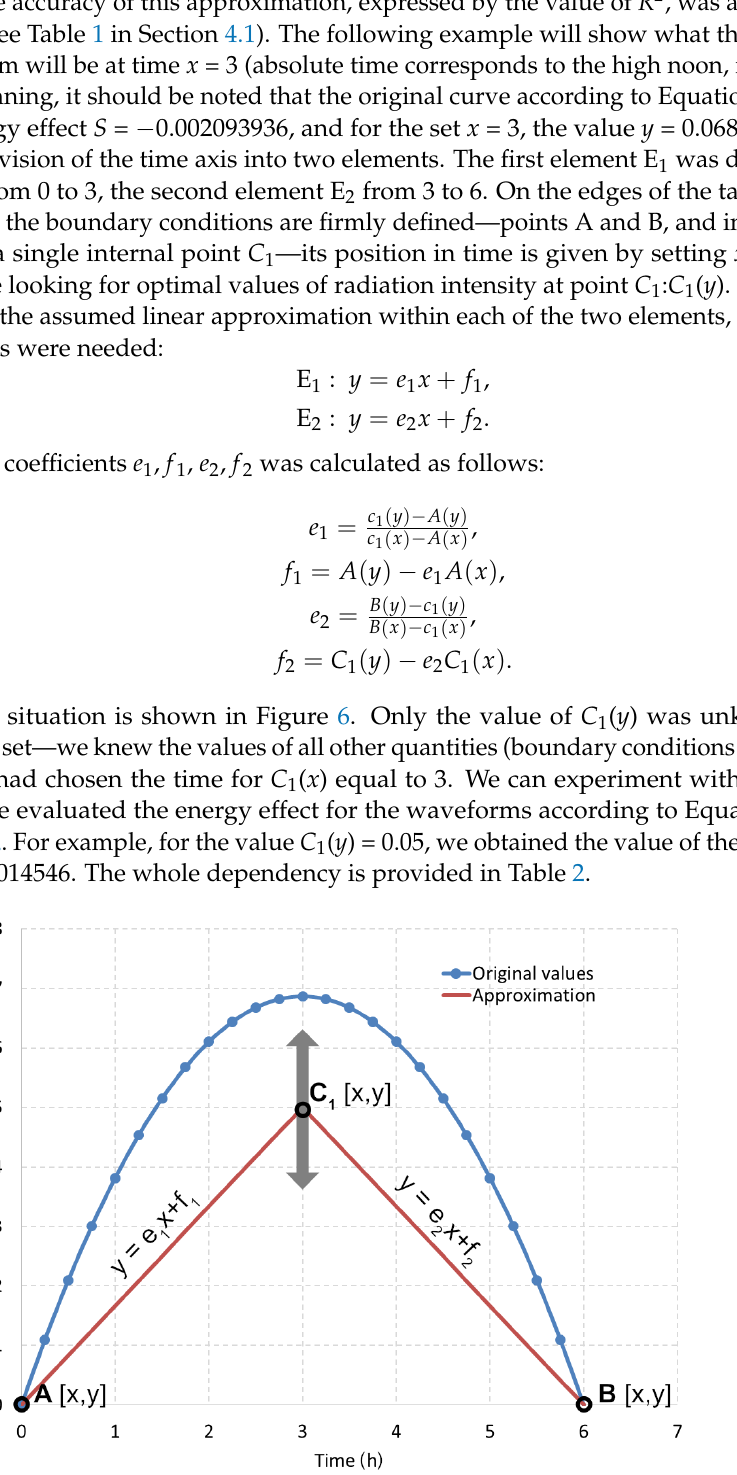
Figure 6. Linear approximation of the